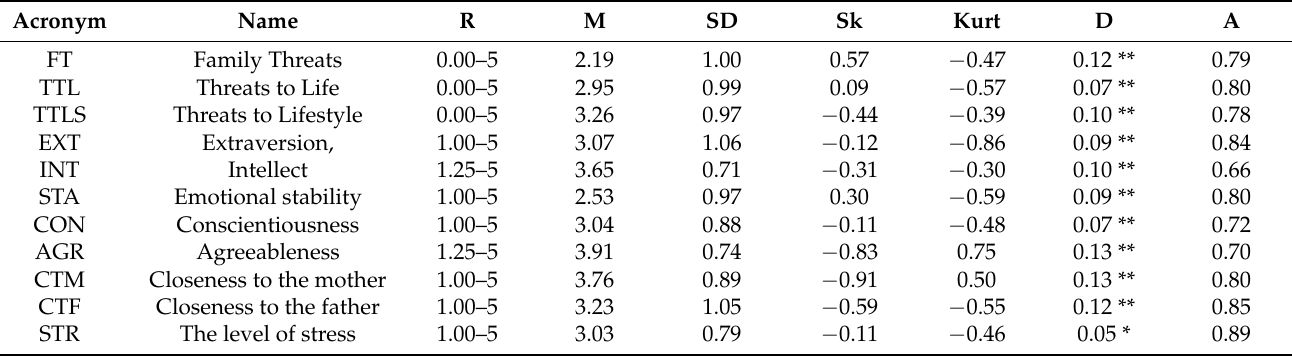
Table 2. Descriptive statistics of variables (N = 405).